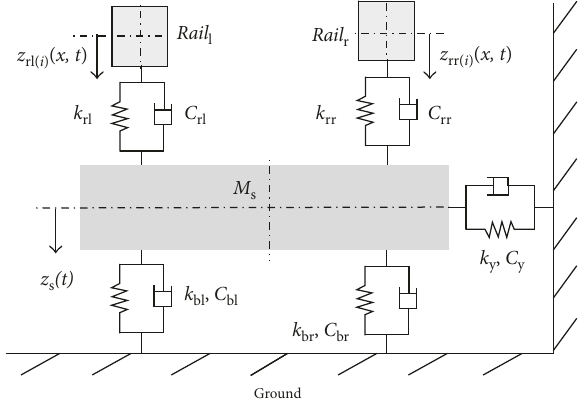
Figure 4: Moving mass track